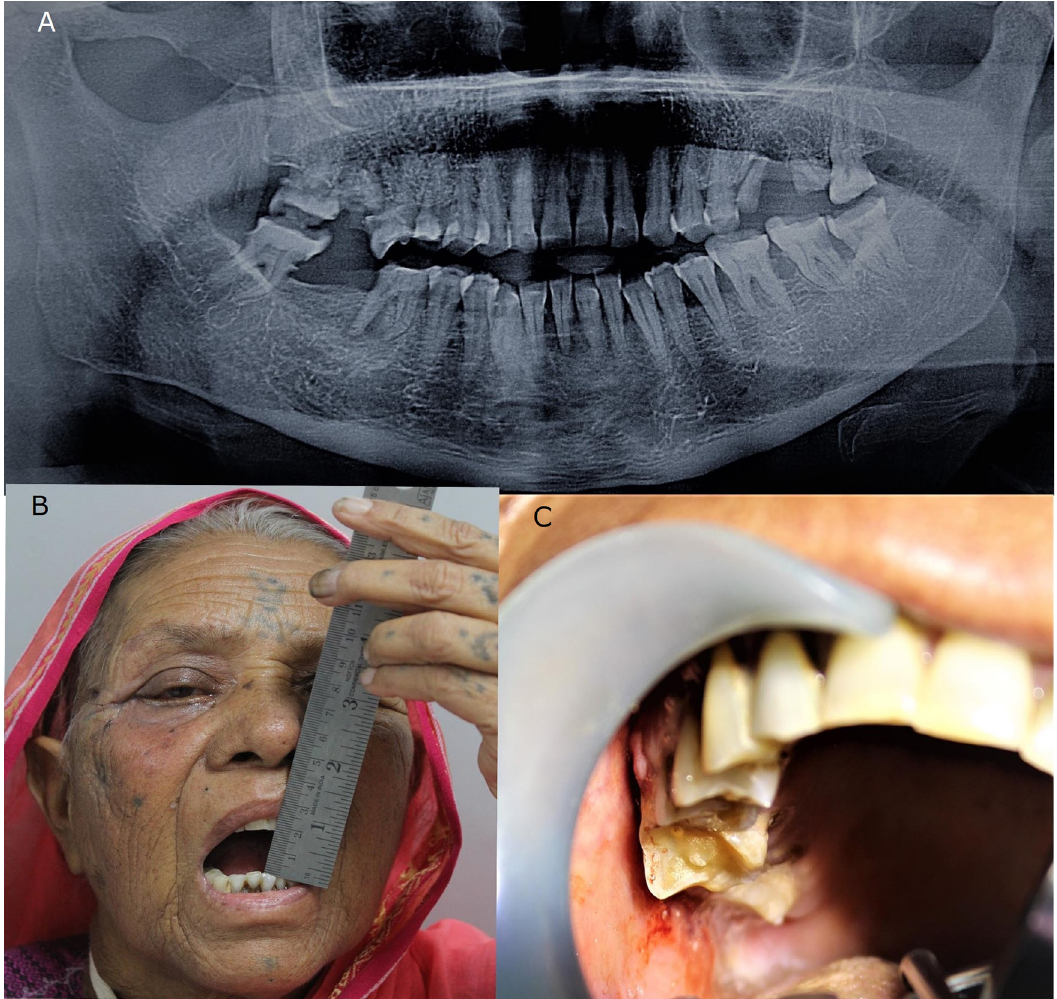
Fig. 3. OPG showing carious molars in right posterior maxilla (A), Regression of facial and orbital symptoms after second week (B) and improvement of mouth opening (C).